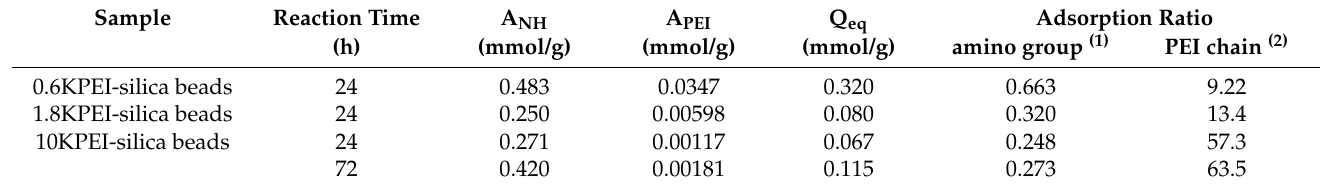
Table 8. The Cr(VI) ion adsorption on silica beads functionalized with GOPTES and